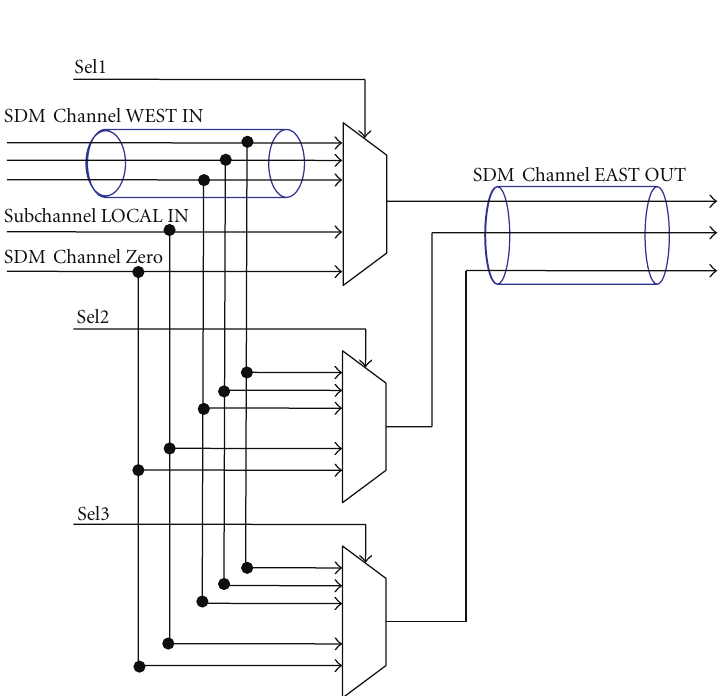
Figure 21: SDM switch EAST